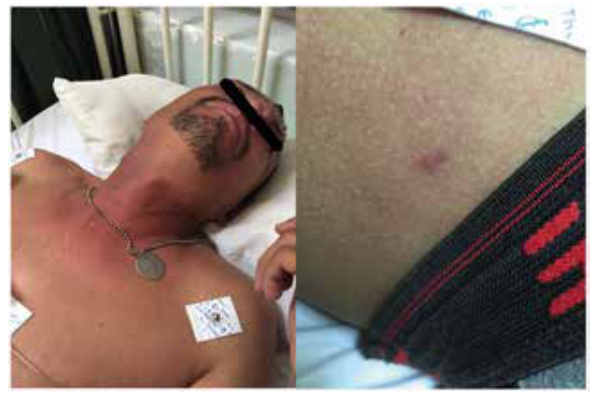
Figure 3: Flushing and bite site with surrounding